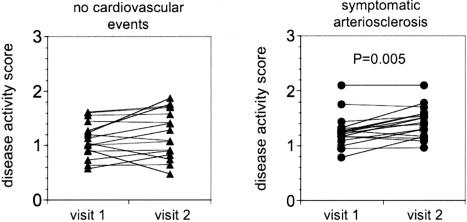
Evolution of the disease activity score with time.A selection of 34 age- and gender-matched patients (16 asymptomatic, 18 symptomatic, median age: 72 years) were reevaluated after 2 years. The disease activity score, assessed on visit 1 and visit 2 was compared using the Wilcoxon test.